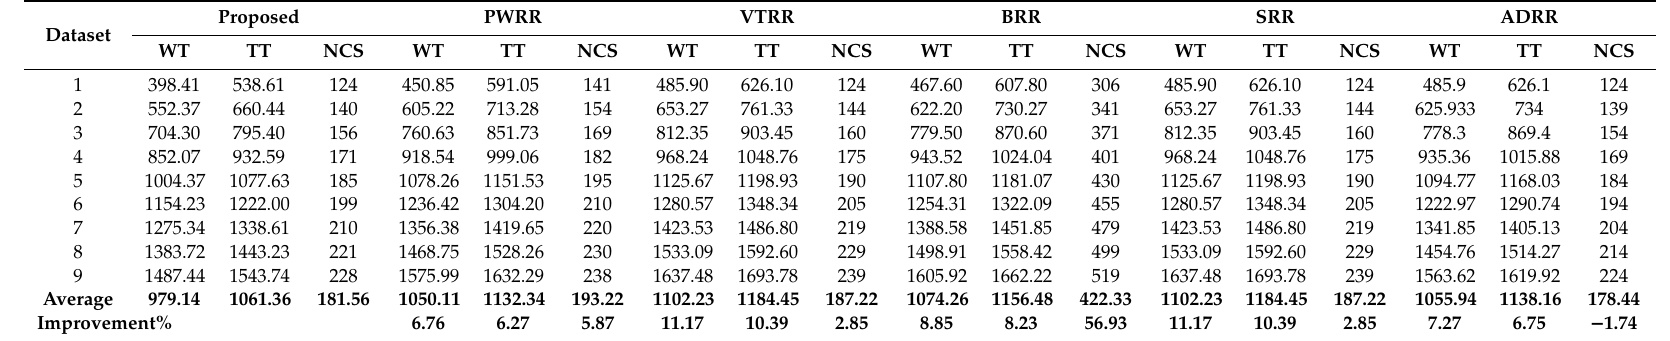
Table A2. Average waiting time and turnaround time comparison between the proposed algorithm and five scheduling